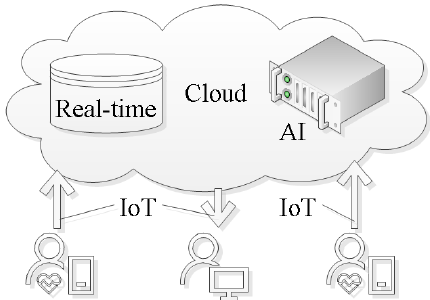
Figure 6. Technologies that underpin atrial fibrillation detection as a